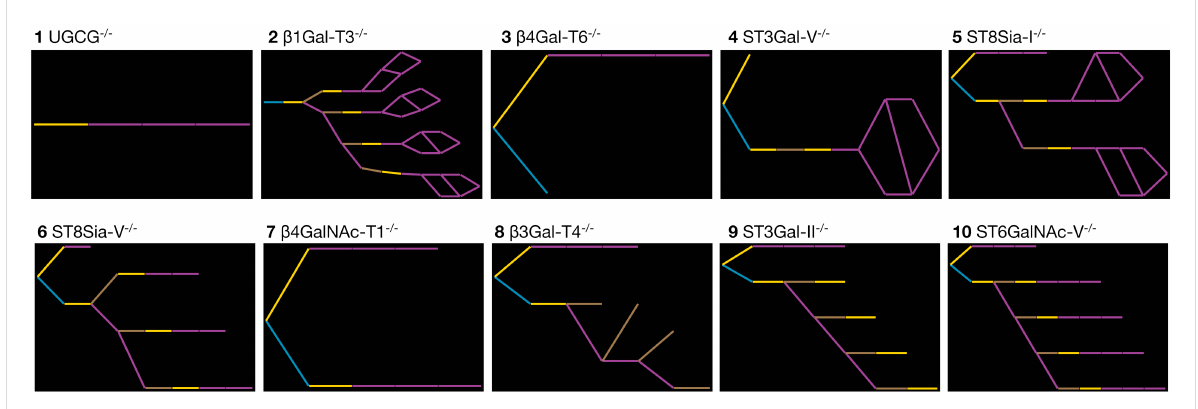
Figure 5: Predicted effects on the pathways of ganglioside biosynthesis when individual enzyme activities are completely inhibited or knocked-out. Panels 1–10 correspond to the enzymes of Table 2. Enzyme reactions are shown as lines colored according to the type of sugar transferred: yellow (galactosyltransferases); blue (glucosyltransferases); brown ( N -acetylgalactosaminyltransferases).